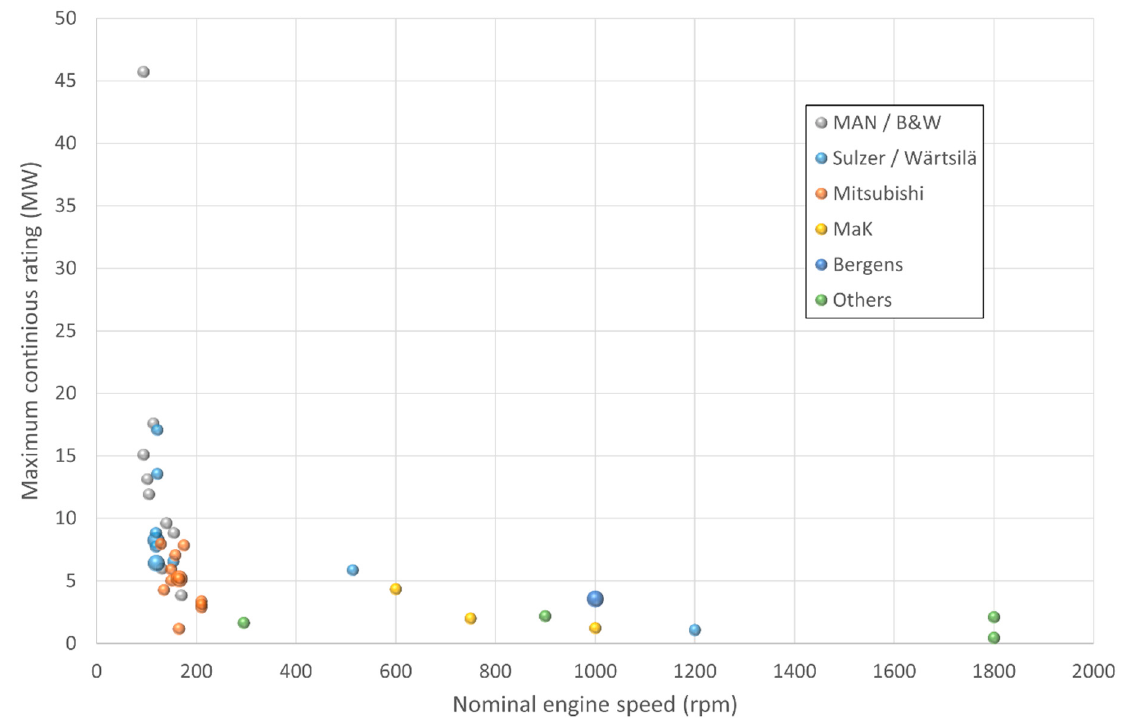
Figure 13. Distribution of main engine turbocharger explosions in the relation to engine nominal speed, maximum continuous power, and the engine’s design.